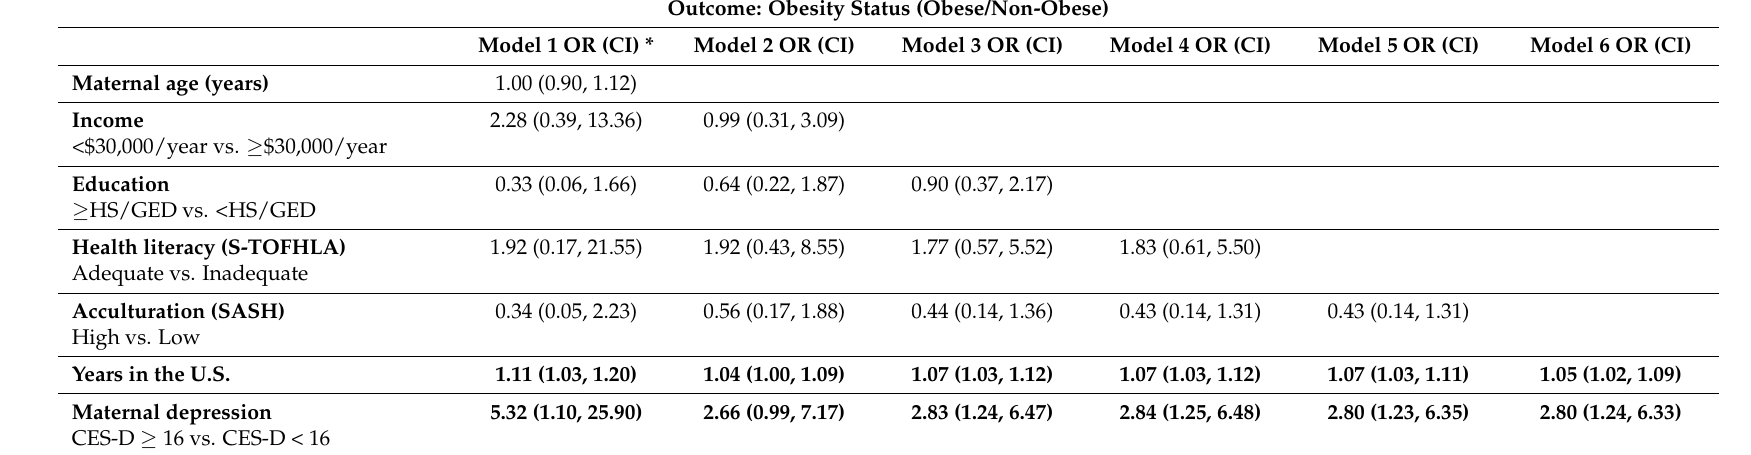
Table 3. Results from multivariable logistic regression models estimating odds of maternal obesity associated with maternal depressive symptoms, controlling for covariates in low-income Latina mothers ( n =